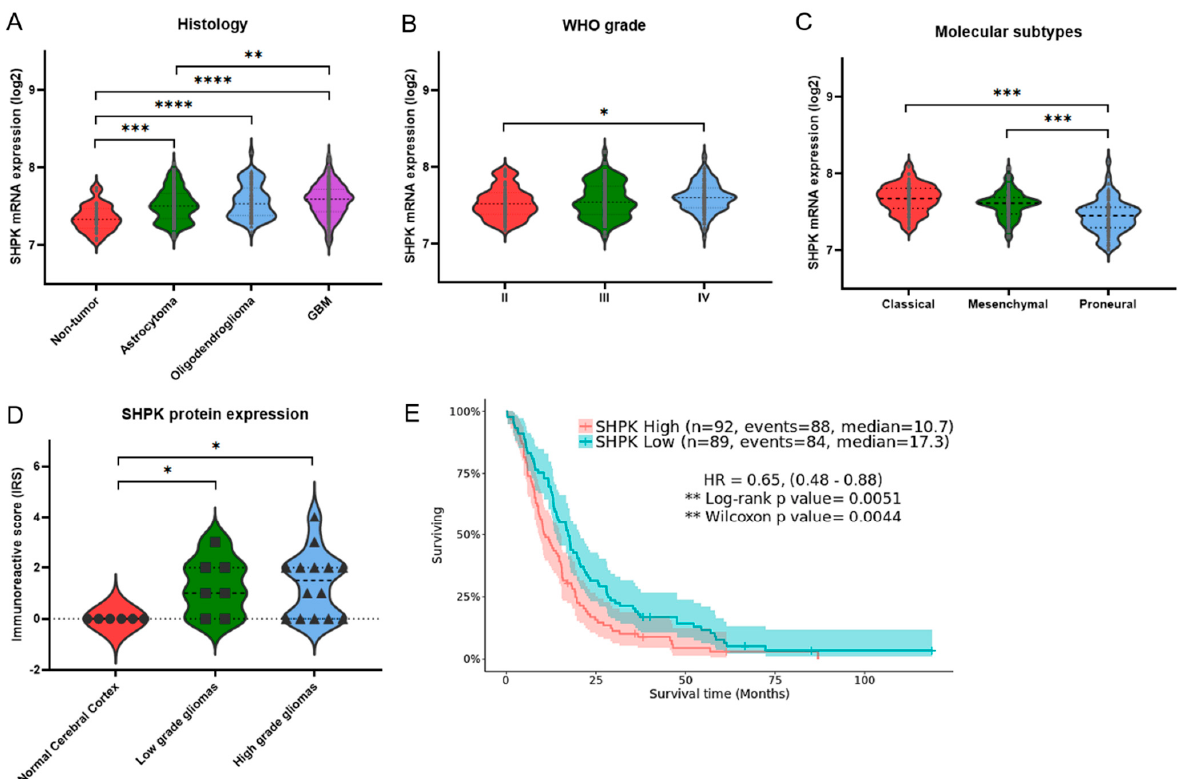
Figure 1. SHPK expression correlates with clinical characteristics and prognosis of GBM patients. ( A ) SHPK mRNA expression within healthy cerebral tissues and different brain tumor histologies. ( B ) SHPK mRNA expression of different WHO-grade brain tumors. ( C ) SHPK mRNA expression in